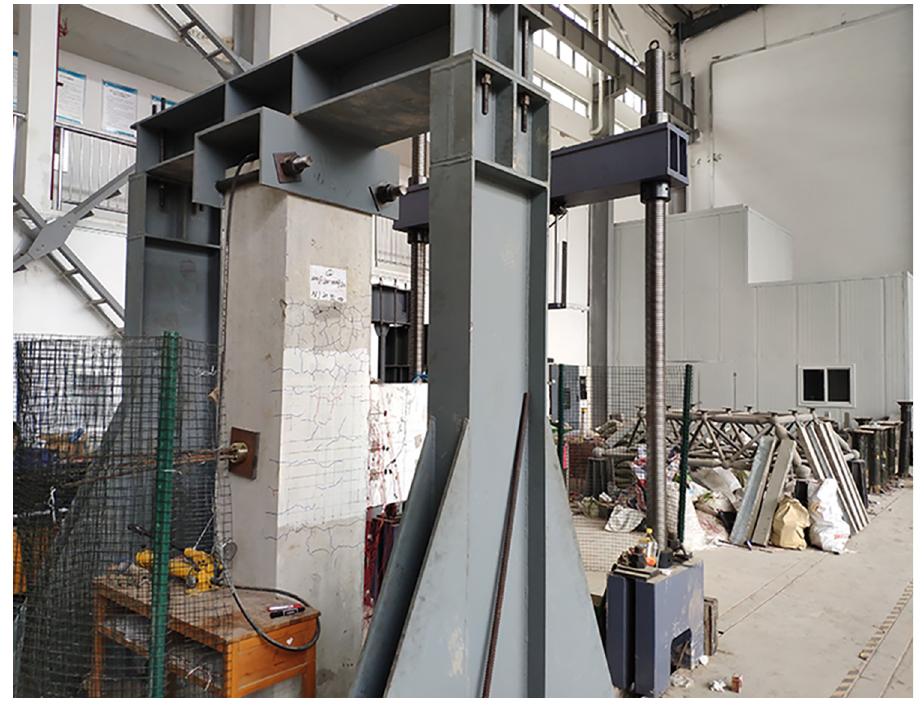
Fig 8. Test loading